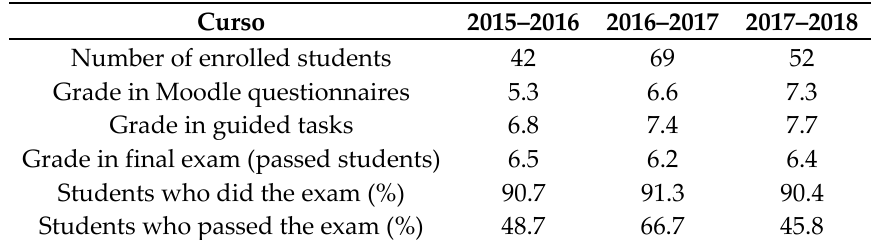
Table 2. Comparison of learning